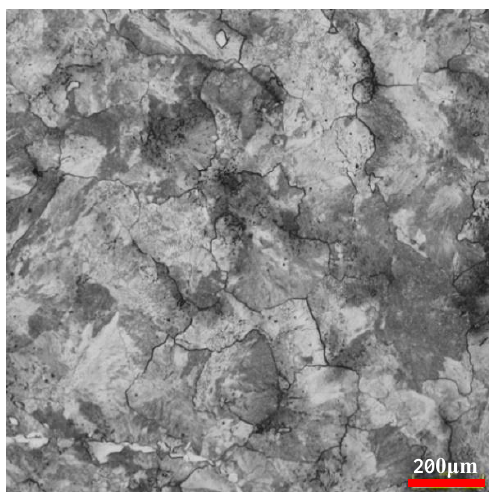
Figure 1. Original microstructure.